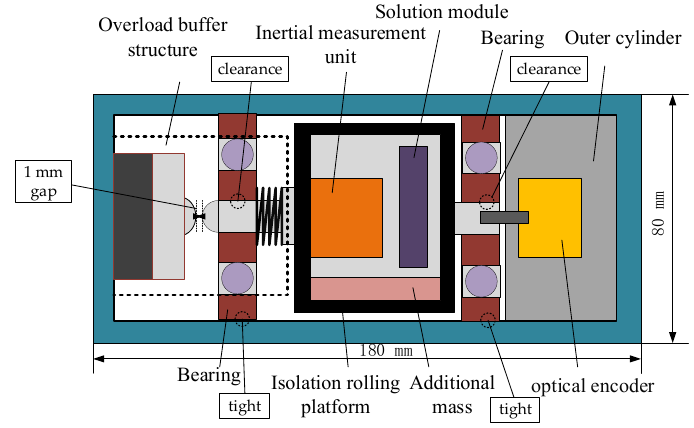
Figure 1. Passive semi ‐ strapdown inertial navigation measurement system.